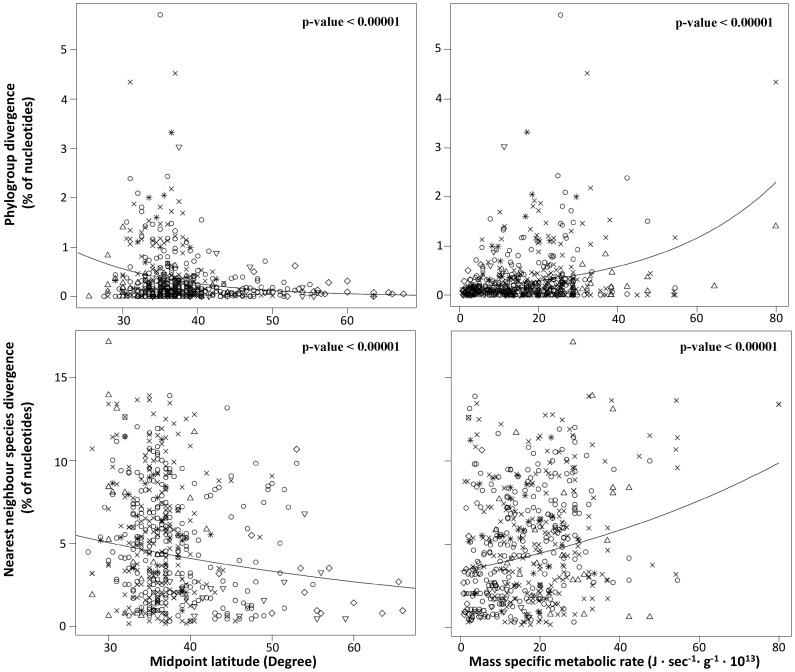
Plots of genetic divergence against midpoint latitude and mass specific metabolic rate using raw data.Each sign represents a different order (○ = Cypriniformes, × = Perciformes, Δ = Cyprinodontiformes, ∇ = Scorpeiniformes, ⊠ = Semionotiformes, * = Siluriformes, ◊ = Salmoniformes, ⊞ = Esociformes). Fitted generalized linear mixed models show a significant relationship between variables in all comparisons (see Table 1).